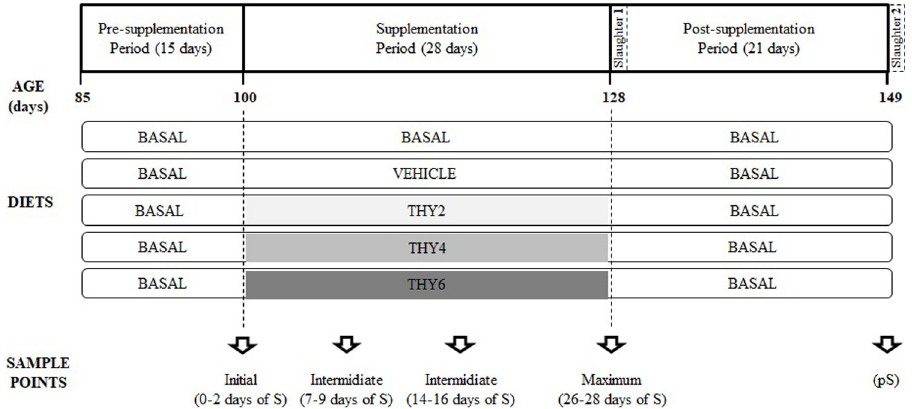
Fig 1. Timeline scheme. The age of the birds (days) is indicated on the horizontal axis. All birds received the basal diet between 85 and 100 days of age. From 100 to 128 days of age, females were subjected to chronic